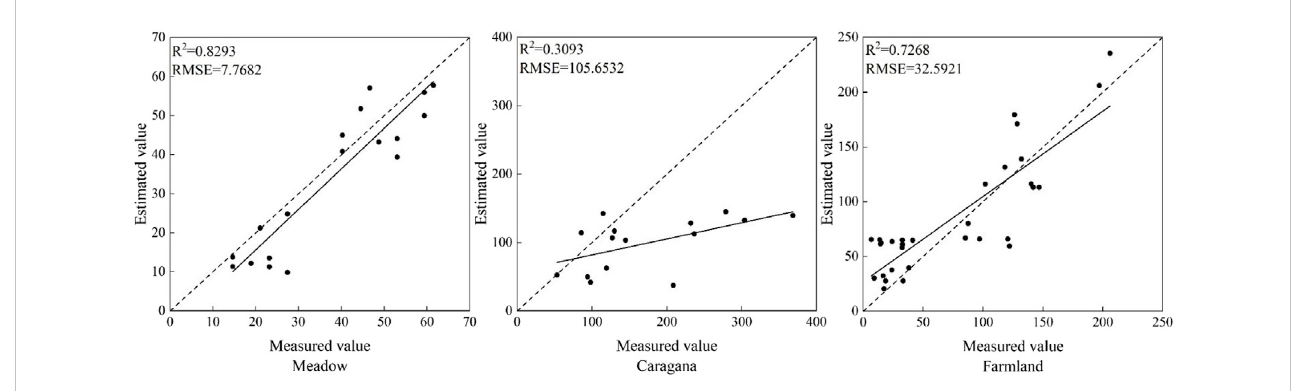
FIGURE 5 Comparison chart of estimation results.